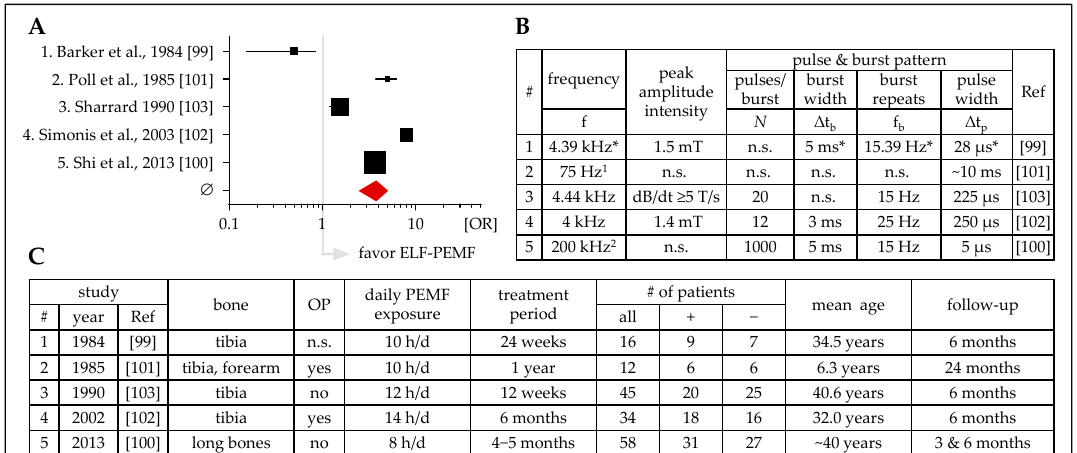
Figure 3. Overview on clinical studies (prospective, placebo-controlled, blinded) investigating the effects of ELF-PEMF treatment on healing of pseudarthrosis/non-union fractures. ( A ) Forest plot showing OR ± 95% C.I.—sum was calculated as described by Neyeloff et al. [107], with weighting based on sample size. ( B ) Tabular overview of the ELF-PEMF used in the presented studies. ( C ) Tabular overview of the presented studies including affected bones, number of patients, treatment, and follow up. 1 BIOSTIM ® , IGEA S.p.A., Carpi, Italy; 2 Orthopulse ® II, OSSATEC, Uden,